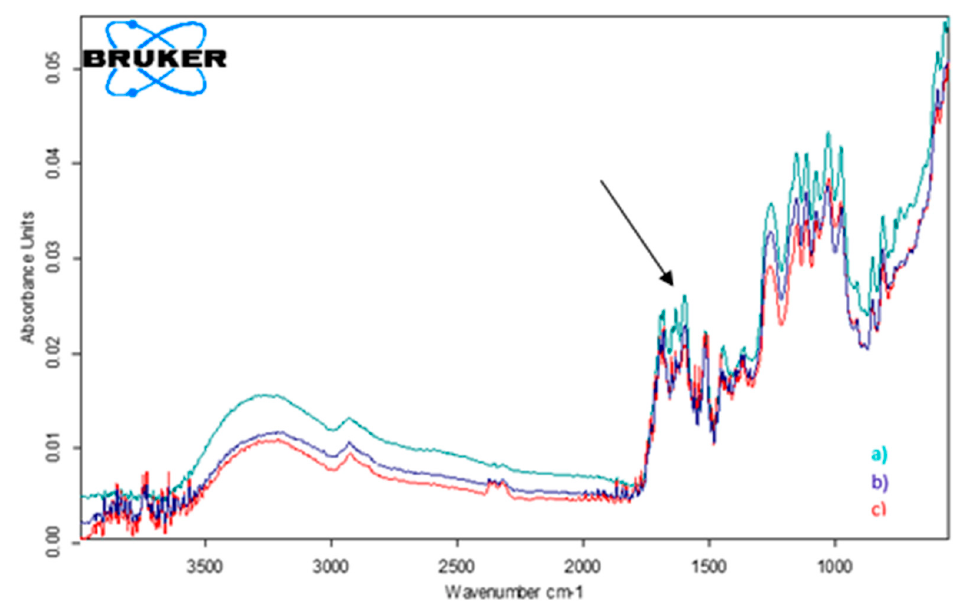
Figure 9. FTIR normalized spectra of ( a ) Green Coffee Extract (Rotta Natura); ( b ) Green Coffee (Pro Natura); ( c ) Green Coffee Fit (Pro Natura).